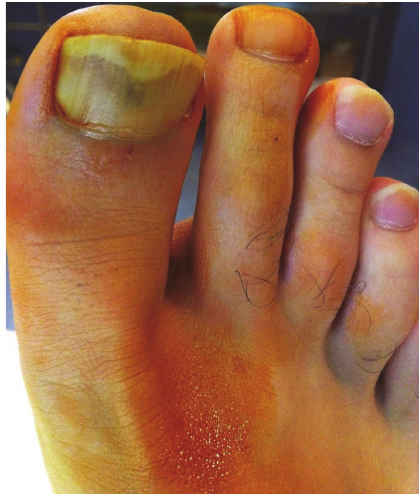
Figure 1: Subungual hyperkeratosis and a round reddish area in the middle of the nail plate.